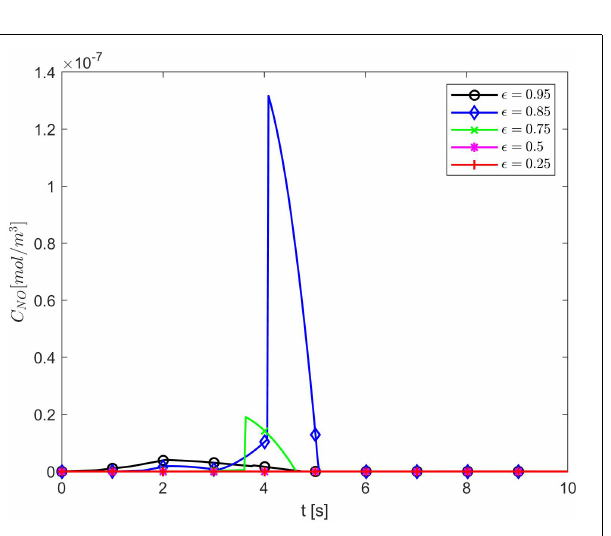
the NO concentration, for p = 0 . 25 , q = 0 . 75, is higher